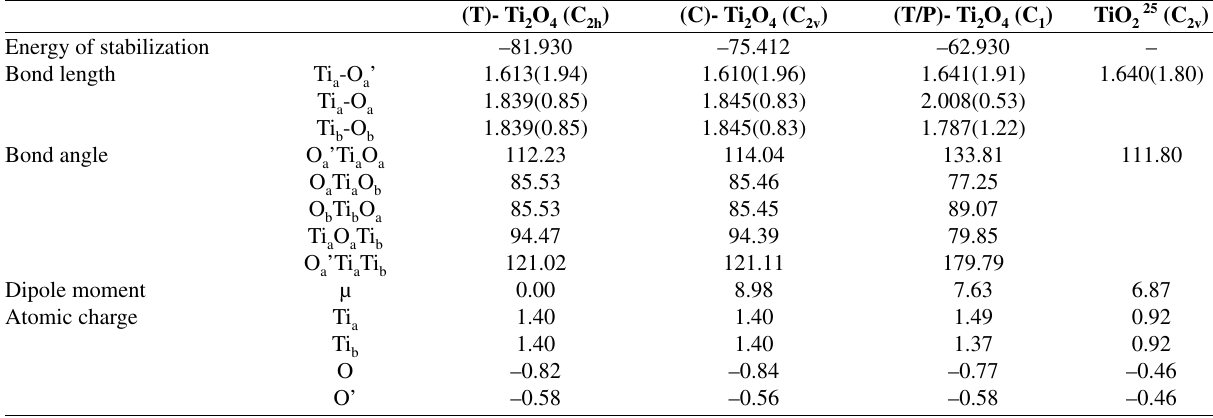
Table 1. Energy (in kcal mol –1 )and selected geometrical parameters (Bond length in Å and angles in degrees) of TiO separated TiO molecules is considered as reference. Wiberg bond index is indicated in parenthesis. 2